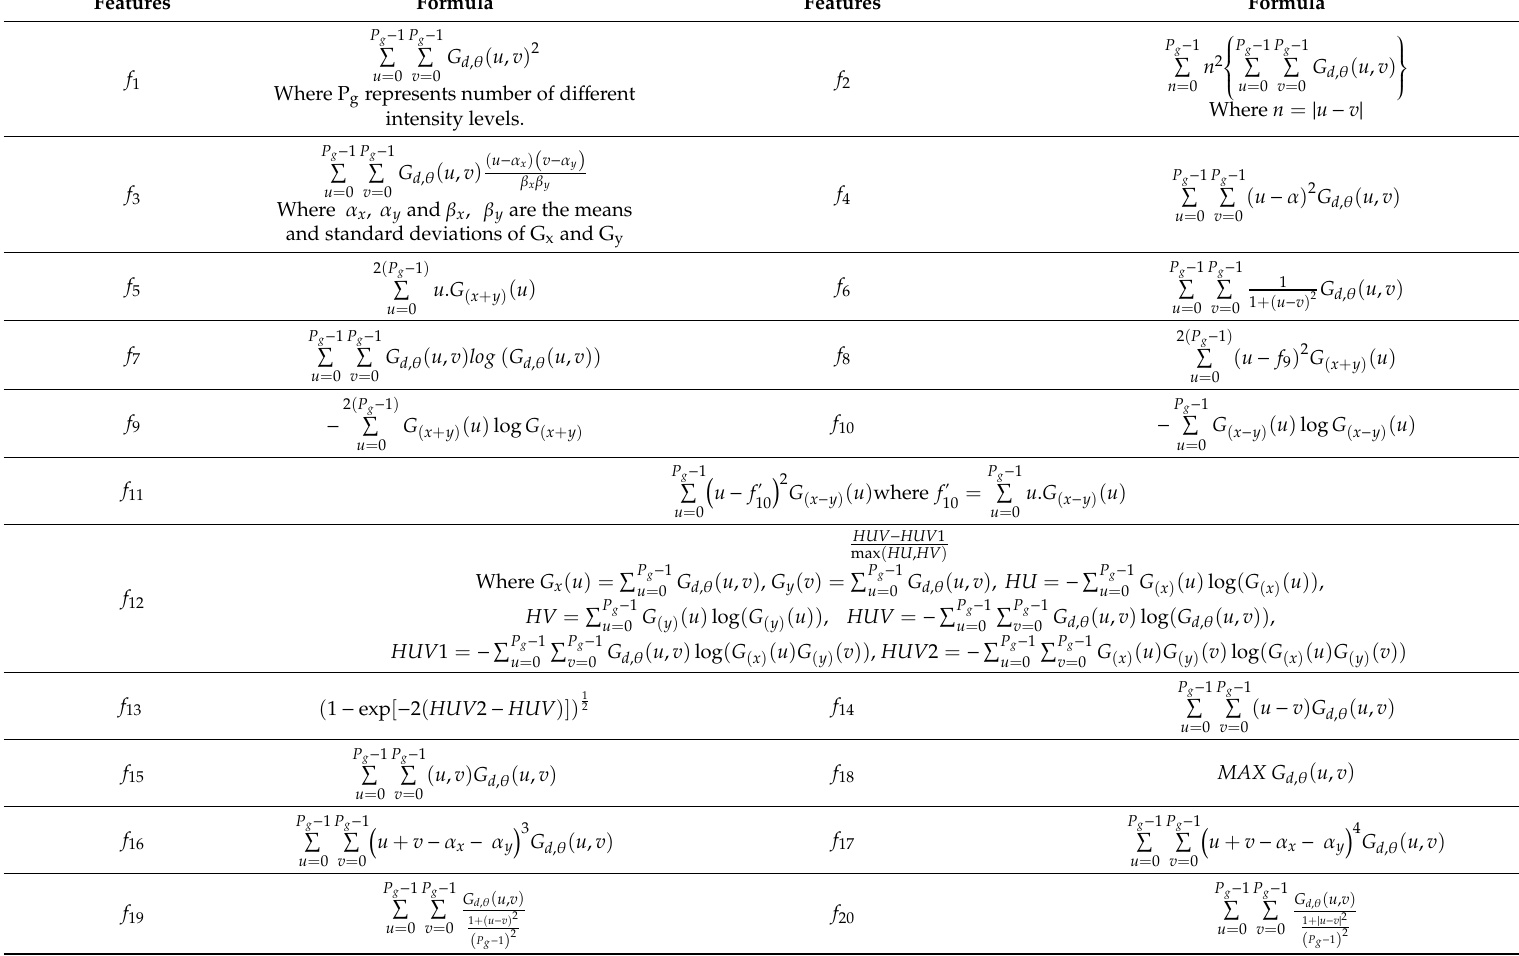
Table 2. Formula GLCM